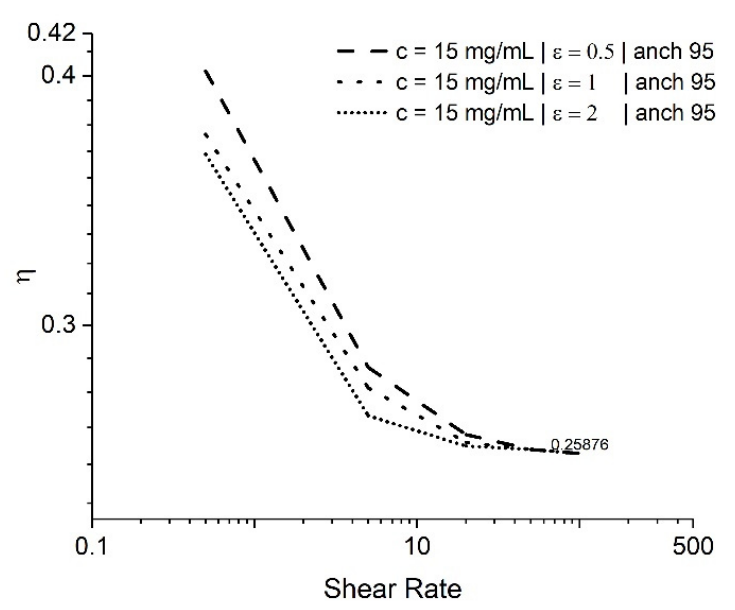
Figure 11. Dimensionless viscosity vs. shear rate in the sensitivity study of Frank coefficients using the EL theory.